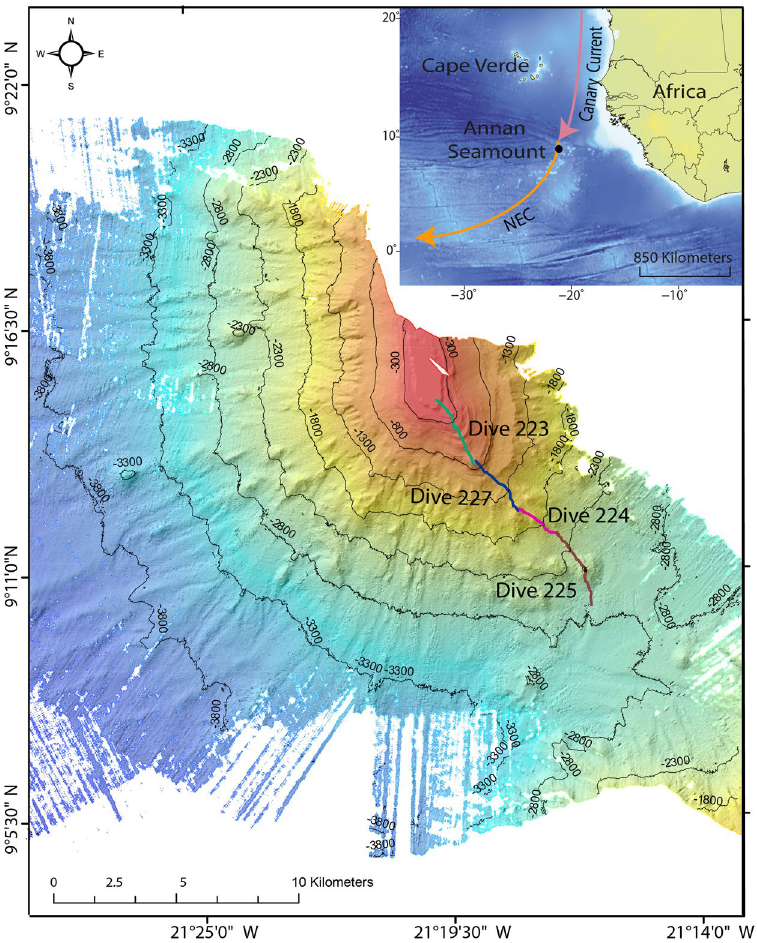
Figure 1. Map of the south-west section of Annan Seamount showing the location of the ROV tracks with bathymetry of 25 m pixel resolution. NEC = North-Equatorial Current. The site map was created in ESRI ArcMap (version 10.2.2). The insert map is ETOPO1 relief data created using Generic Mapping Tools 66 .